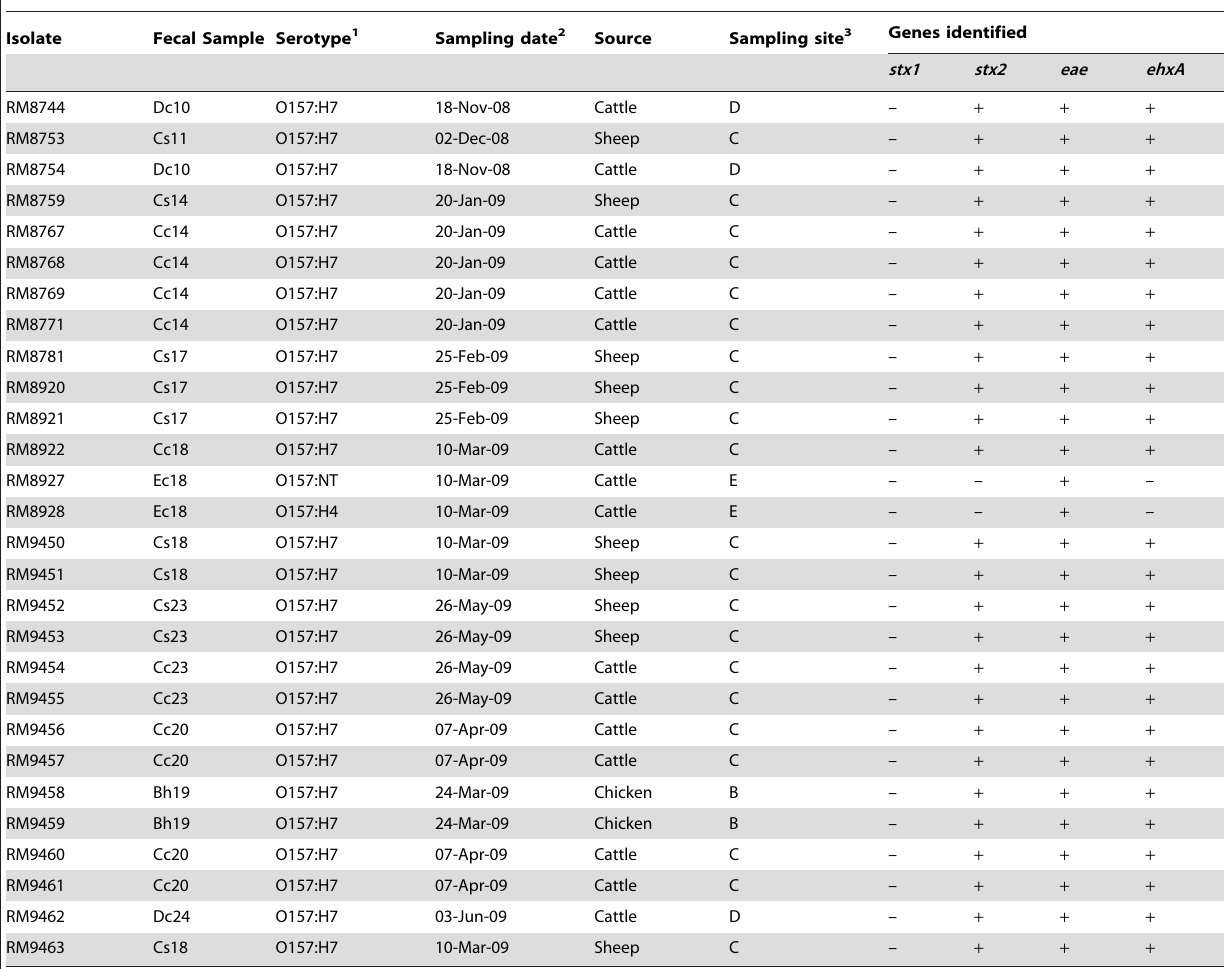
Table 2. List of E. coli O157 isolates used in this study.